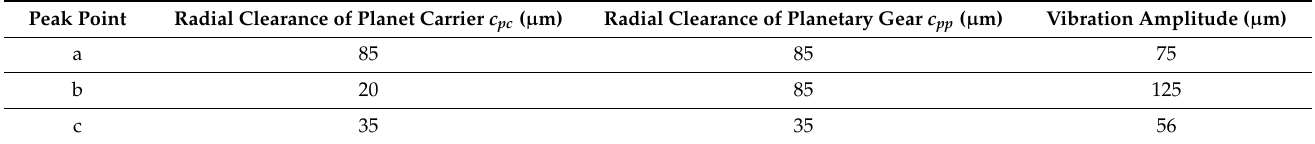
Table 5. The peak value radial vibration for antenna reflector in Figure 9b.